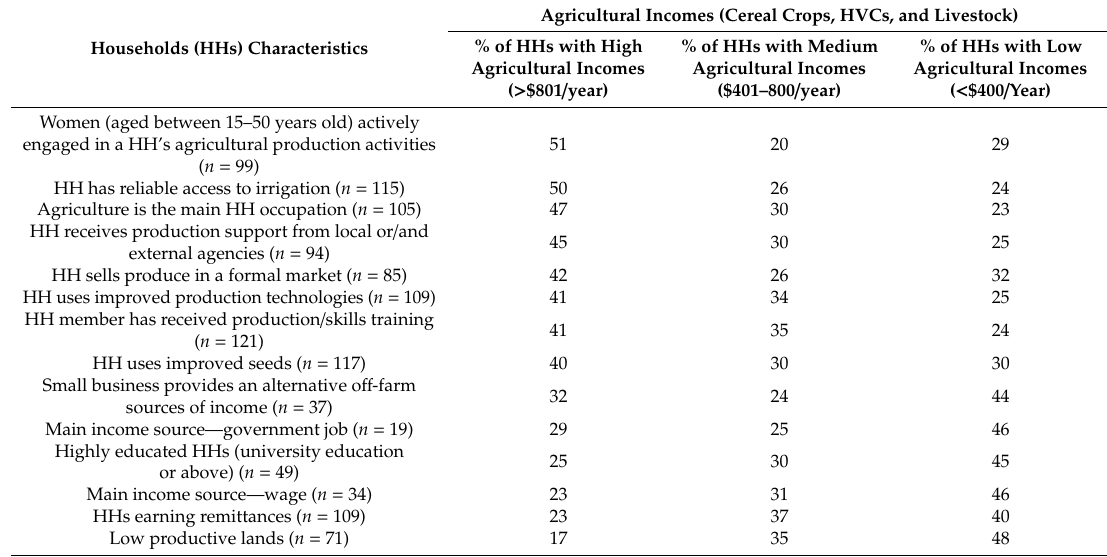
Table 1. Characteristics of production